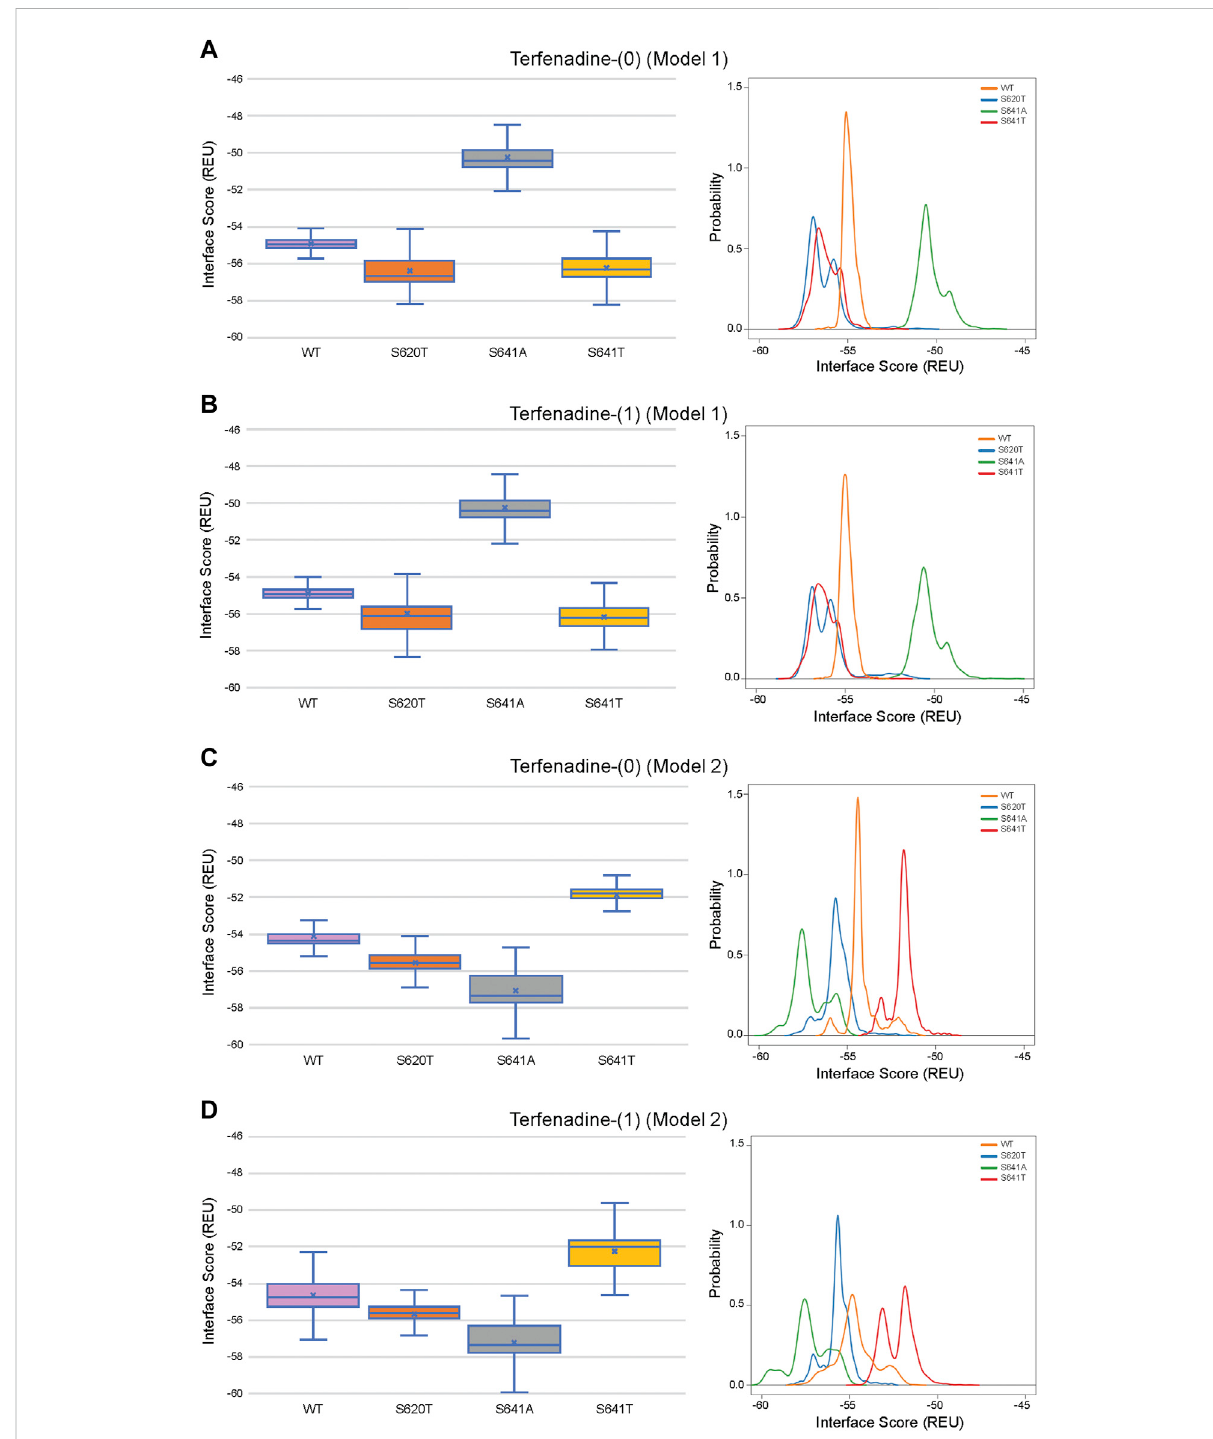
FIGURE 11 Interface score distributions for hERG channel interactions with terfenadine. Left Panels: Box-and-whisker plots of interface scores in REU. Right Panels: Probability density charts plotting probability density against interface scores (REU). All plots utilize 2,000 generated structures. Plots arede fi nedfor (A) neutral(0)model1, (B) charged(1)model1, (C) neutral(0)model2and (D) charged(1)model2structures.ErrorbarsrepresentMax and Min values; Mean (x); Median (horizontal